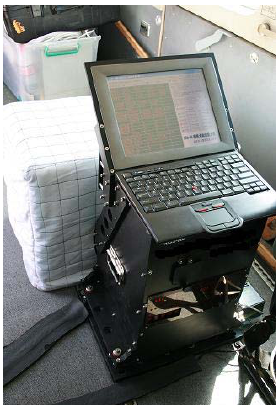
Figure 1. Photograph of the